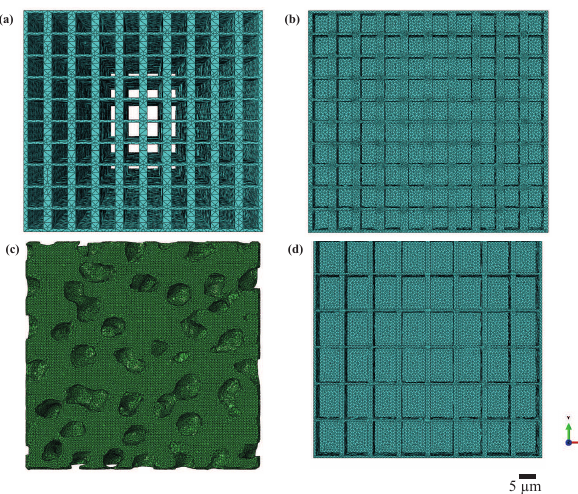
Figure 3. The four computer derived models; (a) The Corridor model, a simple 3-D model; (b) The Compartment model, a com- partmentalised model; (c) The Biological model, the biologically realistic model; (d) The OA model, the compartmentalised model under p CO 2 conditions simulating the year 2050.